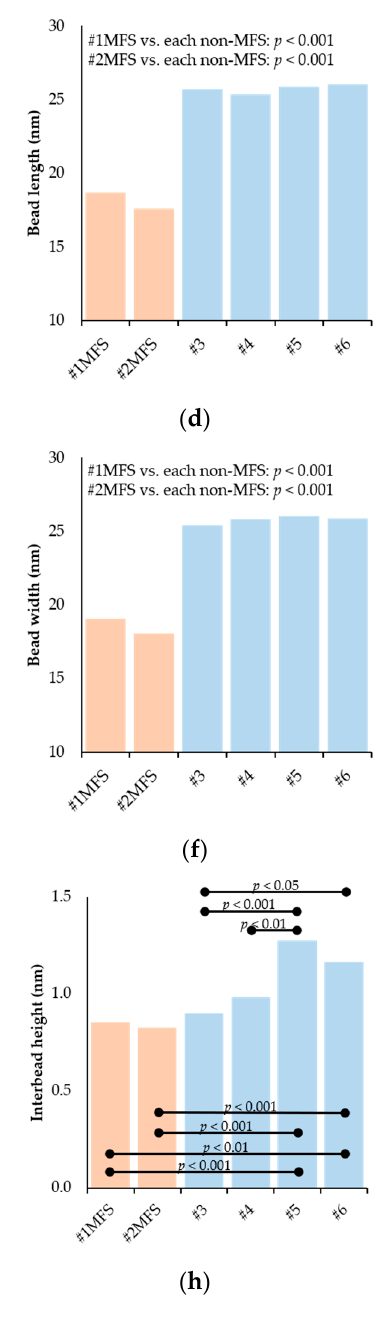
Figure 3. Analysis of the topographical features of fibrillin-1 microfibrils. The left side column shows the statistical comparison of the MFS and non-MFS populations in terms of bead height ( a ), length ( c ), and width ( e ), as well as interbead height ( g ). The right side column shows the statistical comparison of individual samples in terms of bead height ( b ), length ( d ), and width ( f ), as well as mean interbead height ( h ). The horizontal black bars mark the statistically signi fi cant di ff erences between sample means (except for bead length and width, where each of the MFS samples generated statistically signi fi cant di ff erences with each of the non-MFS samples).